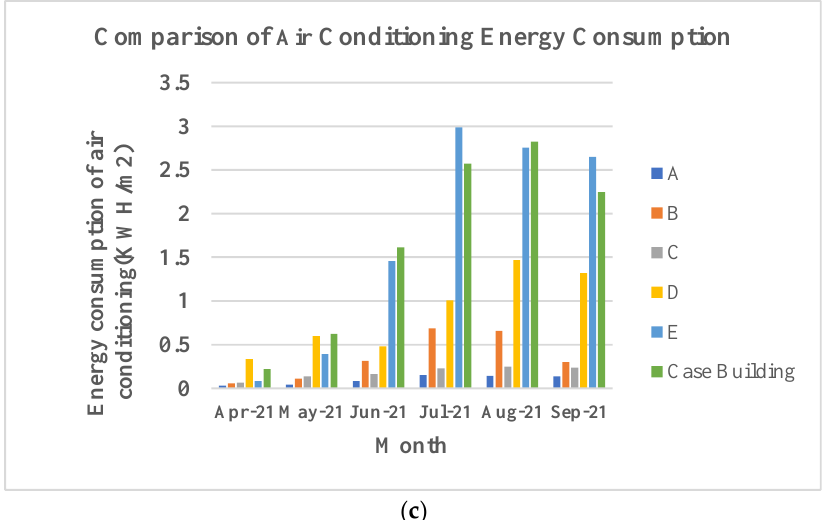
Figure 6. Analysis of Irrational Window-opening behavior and building energy consumption. ( a ). The analyzing process of irrational Window-opening behavior. ( b ). Indoor and outdoor temperatures when windows kept open during intermediate presence: aggregated data for the four occupants. ( c ). HVAC Energy Consumption per unit area of office building during the monitoring period.